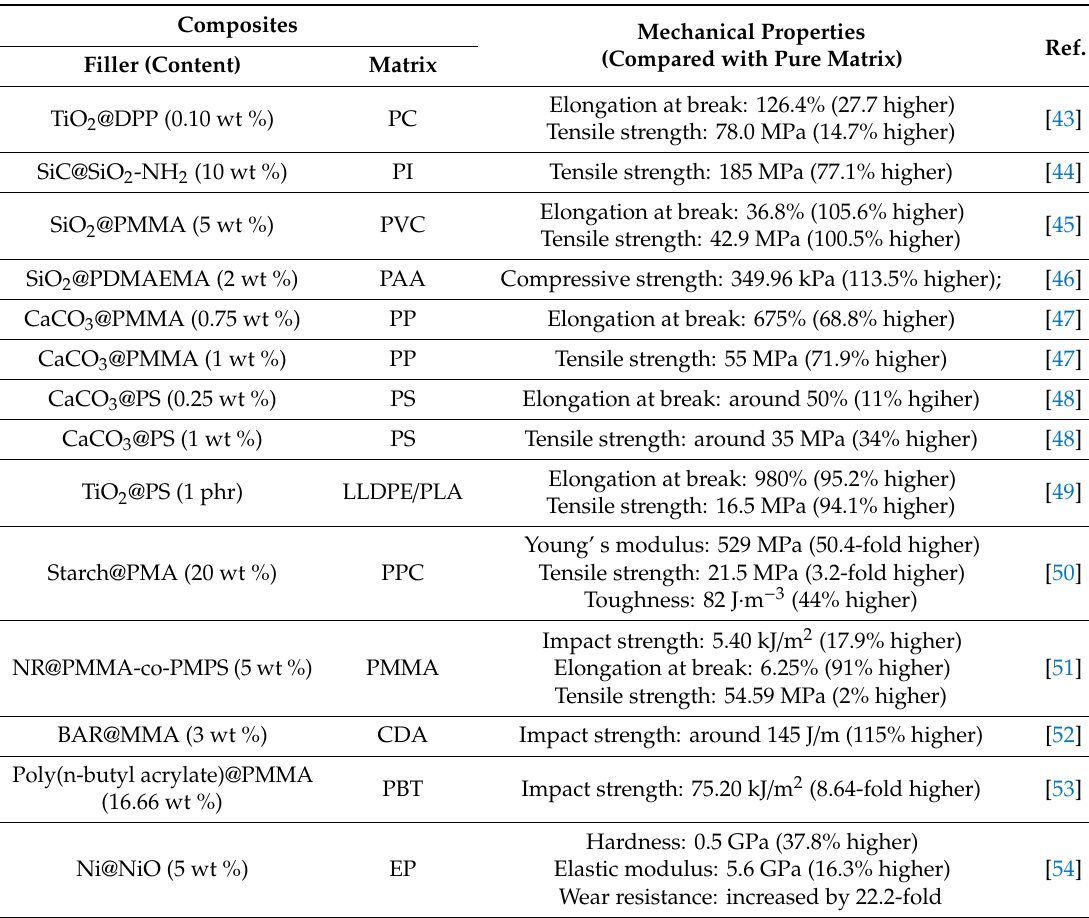
Table 1. Parameters of enhanced mechanical properties. Composites Mechanical Properties (Compared with Pure